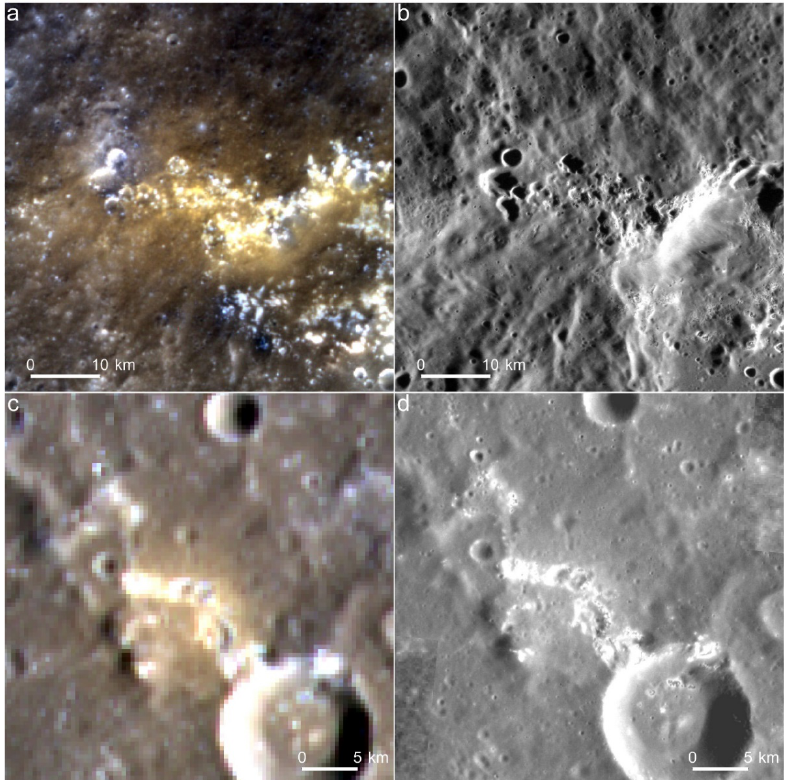
Figure 5. Examples of pitted-ground volcanoes on Mercury. The first column shows color mosaics, and the second column shows monochrome mosaics for the two examples. ( a , b ) The pitted-ground volcano around the Canova crater. ( c , d ) The pitted-ground volcano located in the Chakovskij crater. IDs of the base data used are listed in Table S1.